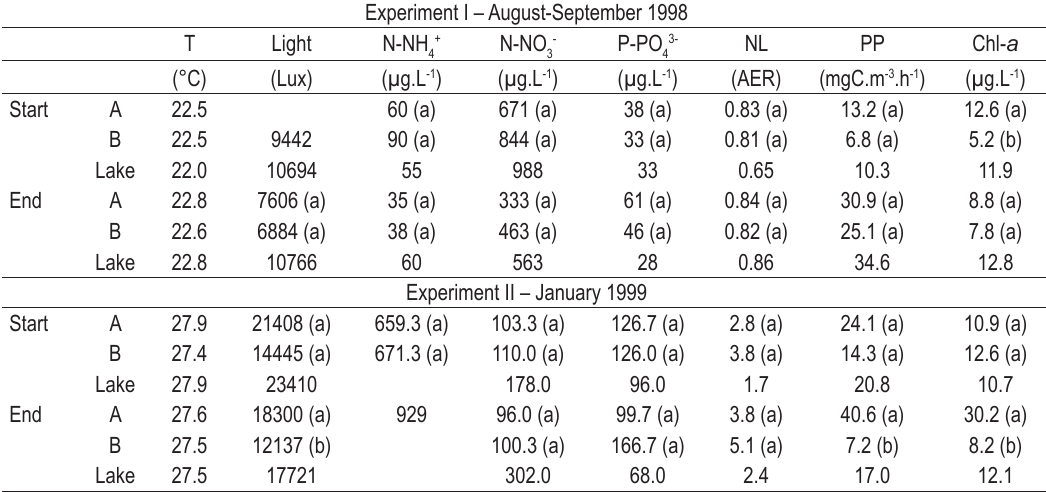
Table 1. Temperature, light intensities, nutrients (N, P), N limitation (NL), primary productivity rates (PP), and chlorophyll- a concentrations in the mesocosm experiments. Different letters indicate significant differences ( post hoc Tukey test, p <